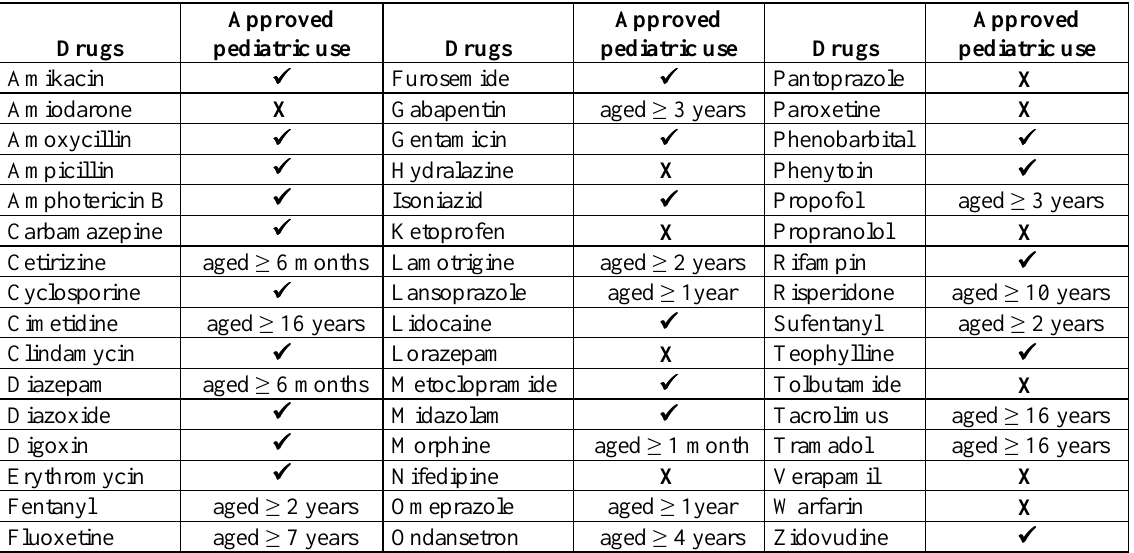
Table 1. Pediatric indication for some drugs by the